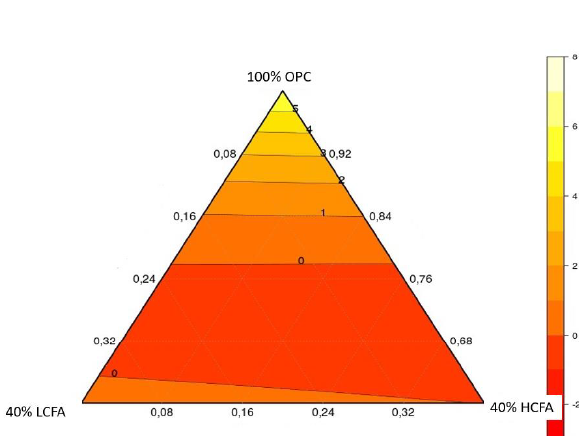
Figure 7: A contour chart for the model from Table 3 - linear strain measure of cement mortars immersed in 5% sulphate sodium